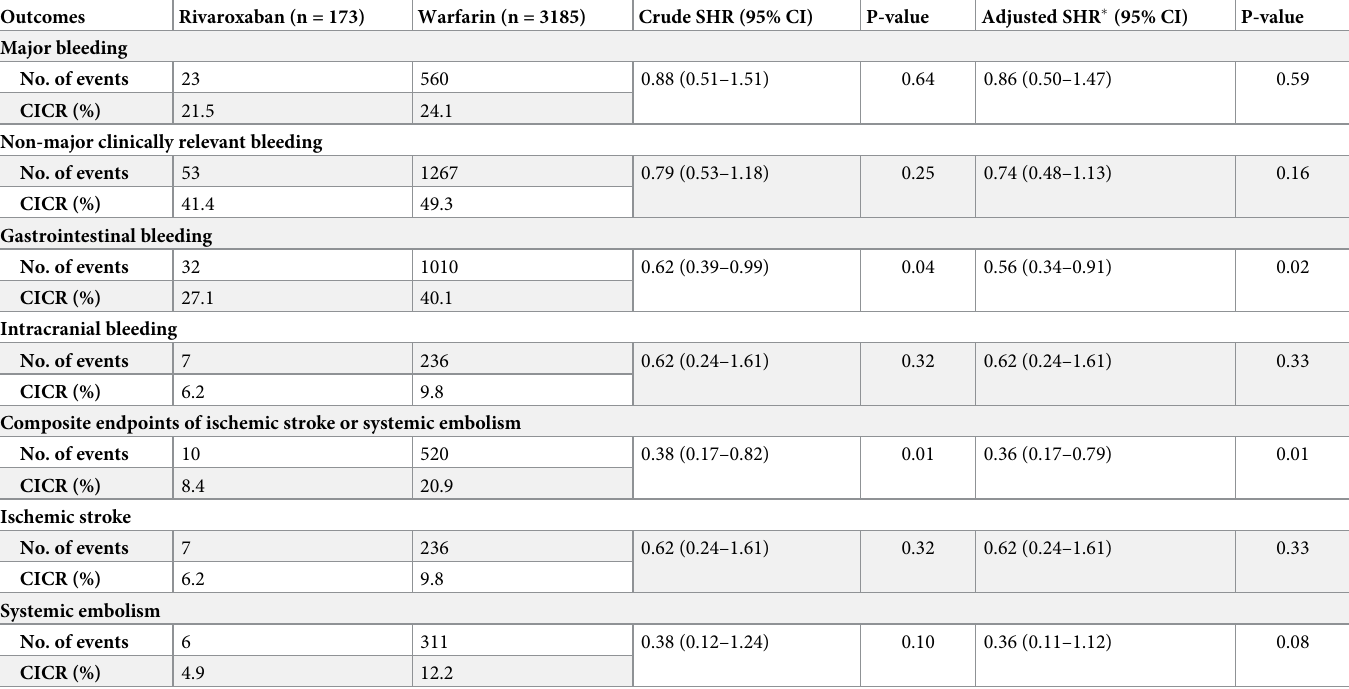
Table 2. Cumulative incidence and SHR of bleeding and thromboembolic outcomes: Rivaroxaban versus warfarin.